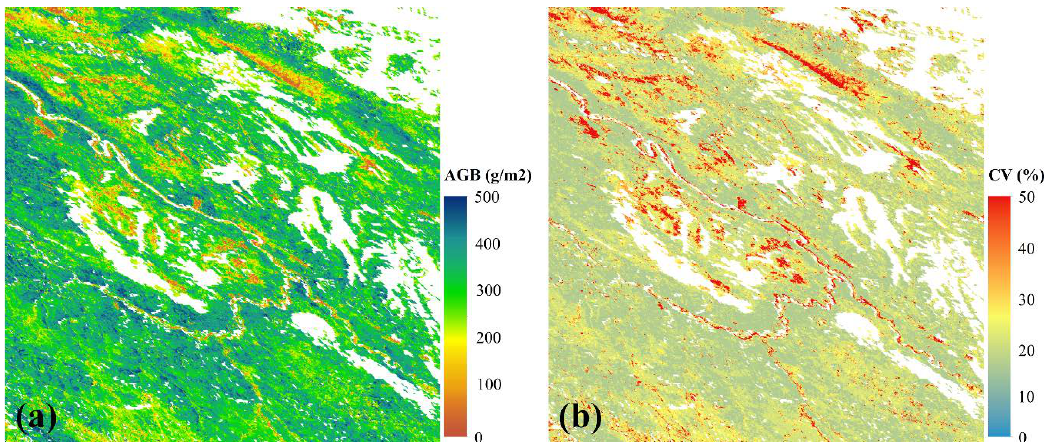
Figure 6. ( a ) Aboveground biomass (AGB) and ( b ) coefficient of variation (CV) maps generated from Gaussian process regression. The white parts represent nongrassland land-cover types.